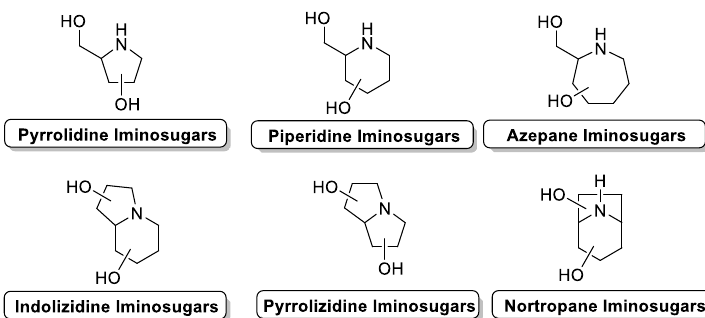
Figure 1. Iminosugar structural motifs of natural and synthetic origin.